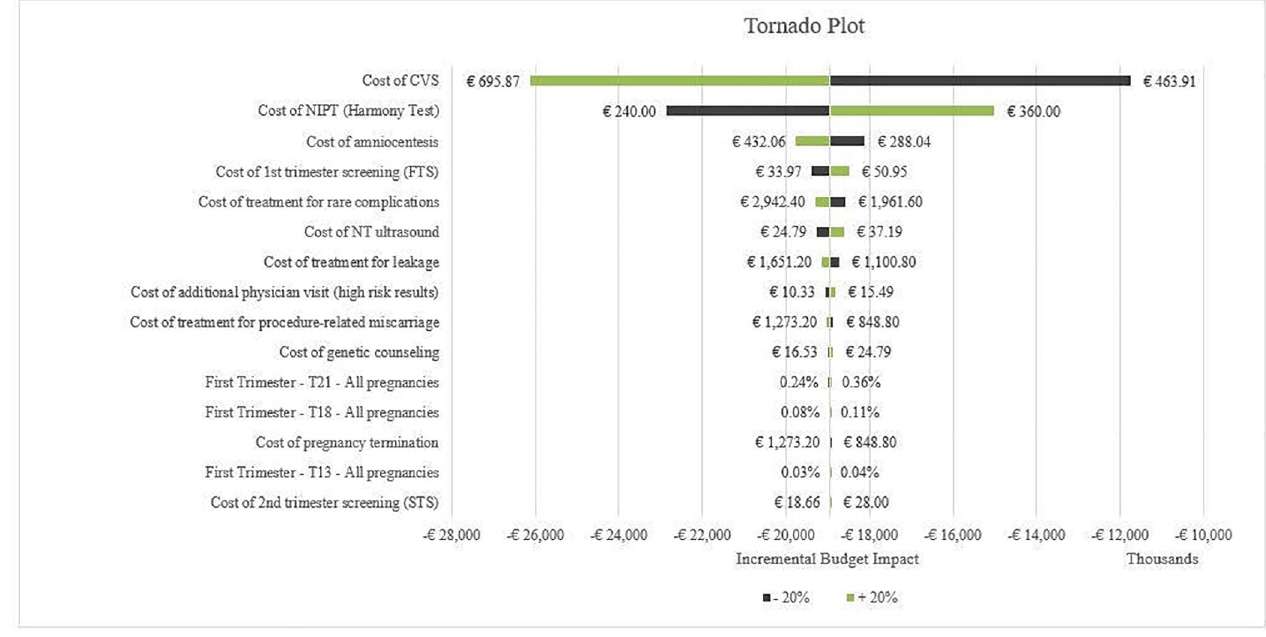
Fig 7. Sensitivity